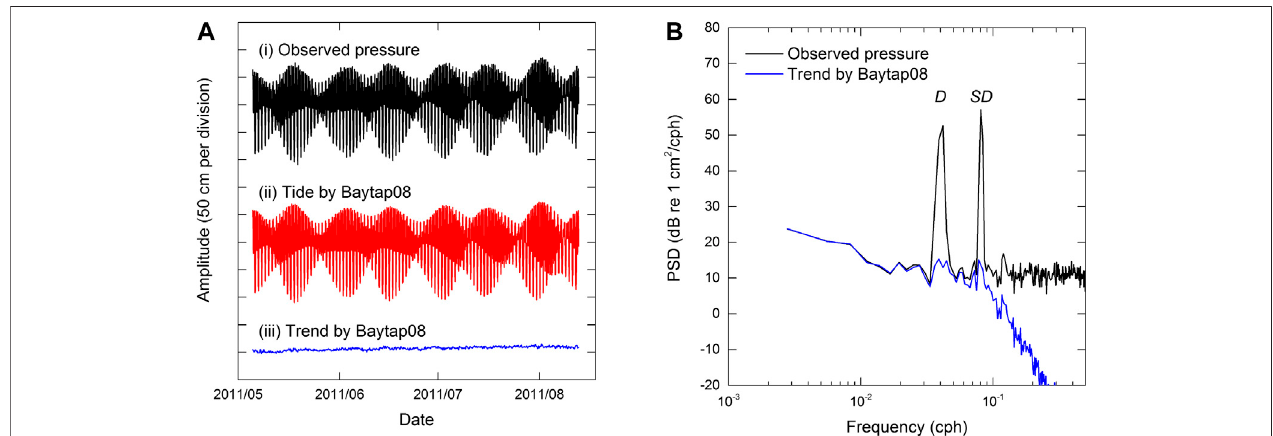
FIGURE 3 | (A) Example of pressure waveforms recorded at KMA01: i) original observed waveform, ii) tide component analyzed by Baytap08, and iii) trend component. (B) Spectrum of the observed pressure and trend component analyzed by Baytap08. D and SD represent the diurnal and semi-diurnal tide components,